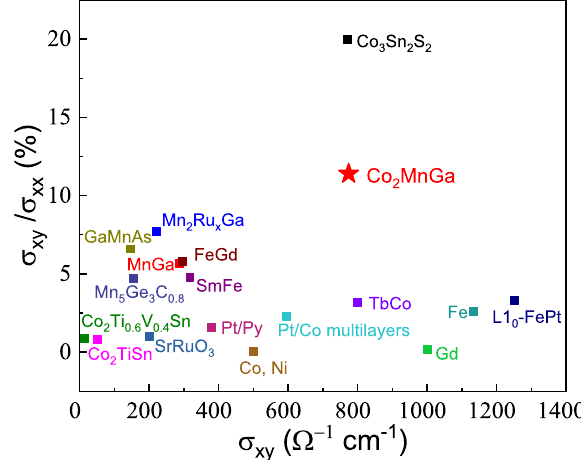
Fig. 5 The σ xy -dependent anomalous Hall angle of our result in comparison with previously reported results for other thin fi lms. The reported results were taken or calculated from references (see Supplementary Table